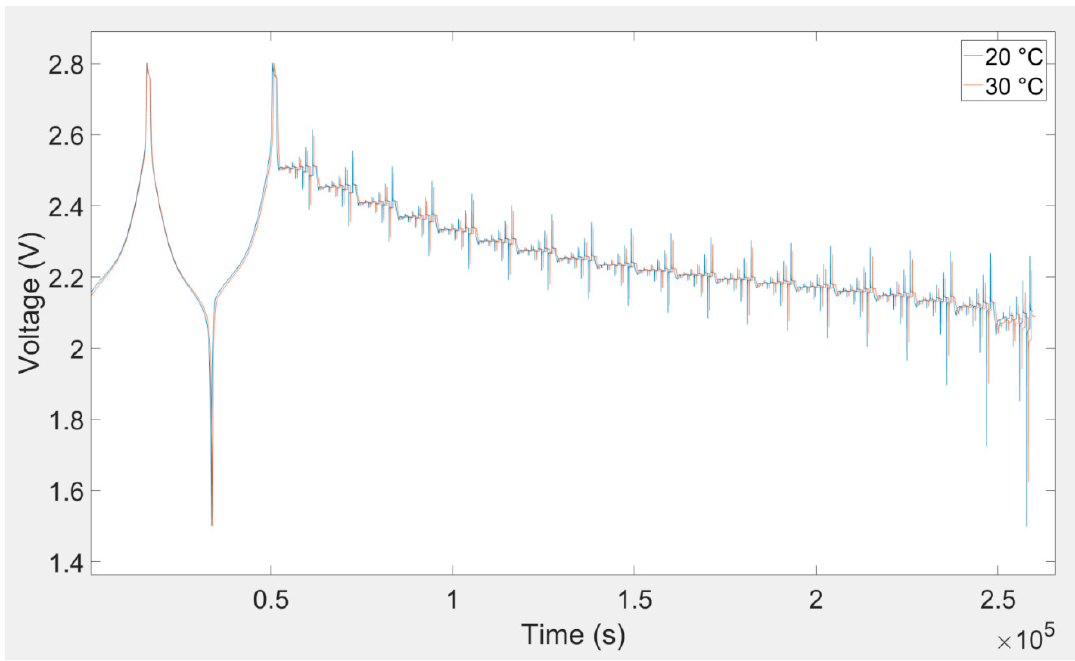
Figure 8. Battery cell voltage response owing to charging and discharging current pulse for 20 °C and 30 °C.